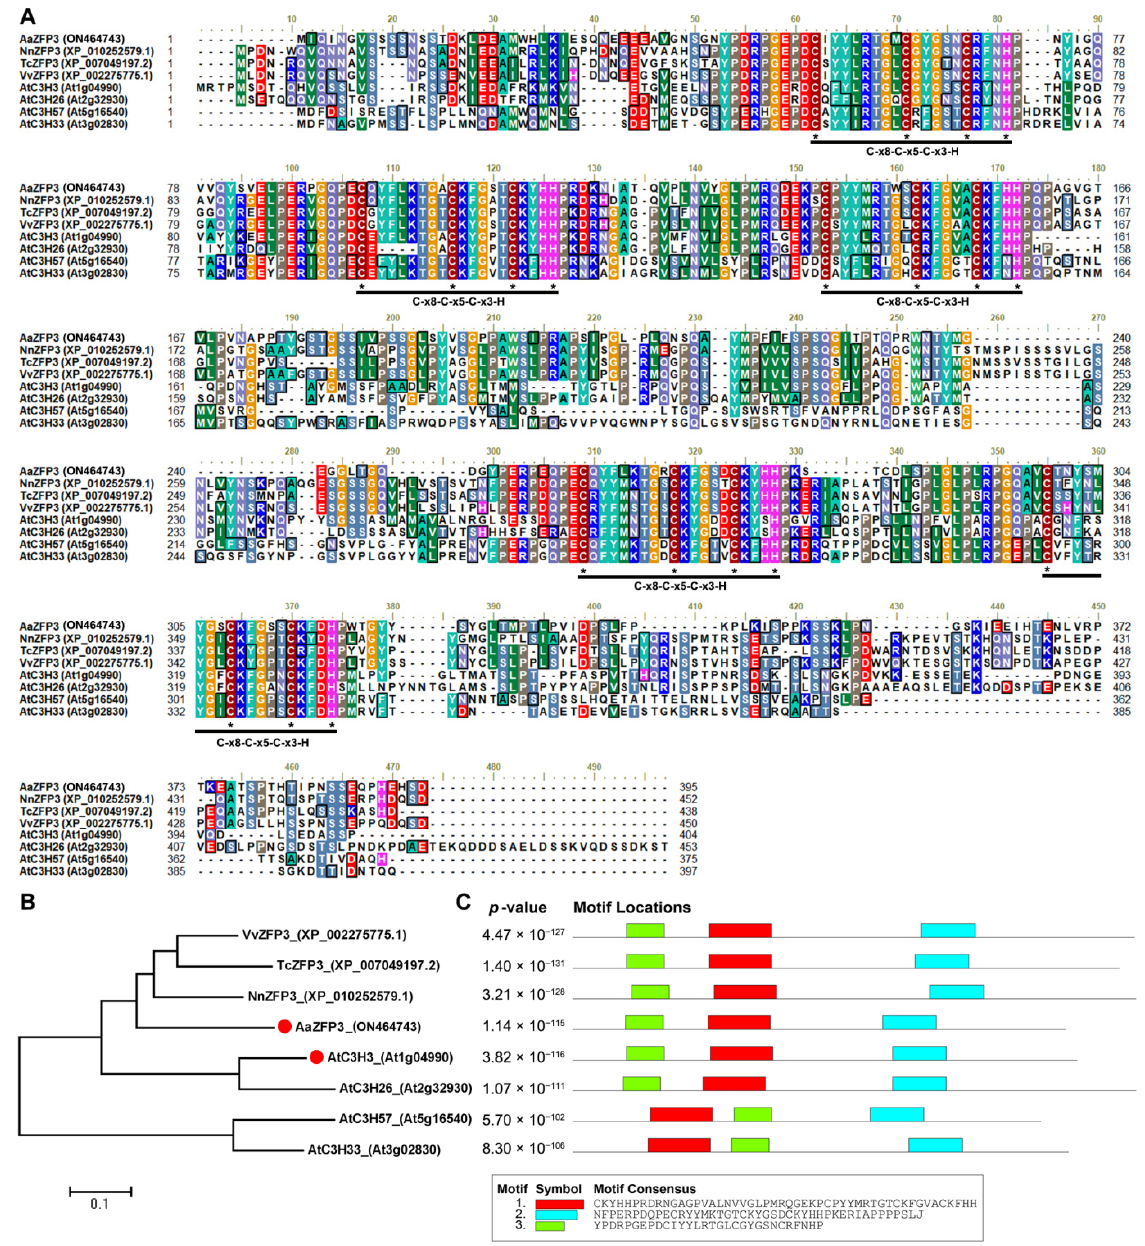
Figure 1. Sequence analysis of AaZFP3. ( A ) Multiple sequence alignment of AaZFP3 with other zinc finger proteins from multiple species, including Arabidopsis thaliana , Nelumbo nucifera , Vitis vinifera , and Theobroma cacao . The Arabidopsis ZFP protein is also known as C3H. Asterisks indicate the conserved cysteine (C) and histidine (H) residues. ( B ) Phylogenetic tree of ZFP3 proteins. ( C ) Conserved motifs of ZFP3 proteins.